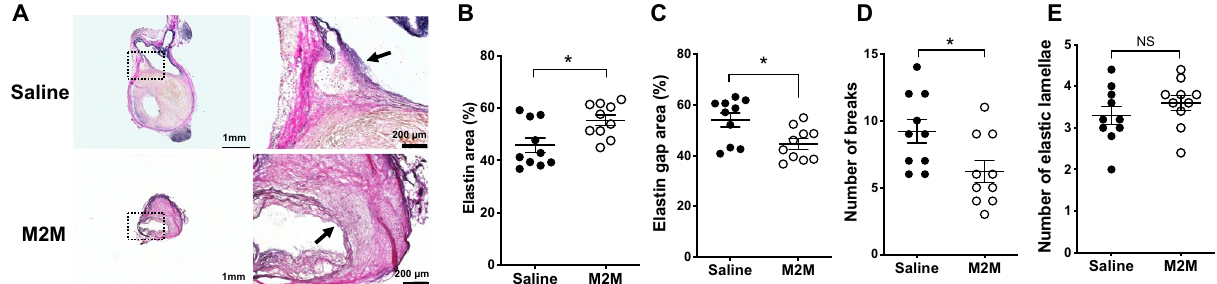
Figure 2. ( A ) EVG staining indicates destruction of the elastic lamellae structure (black arrows). Quantitative analysis of elastin area ( B ), elastin gap area ( C ), number of breaks ( D ), and number of elastic lamellae ( E ). Data are means ± SEM. * p < 0.05 assessed by the Mann–Whitney U test. EVG: Elastica van Gieson. NS: not significant.